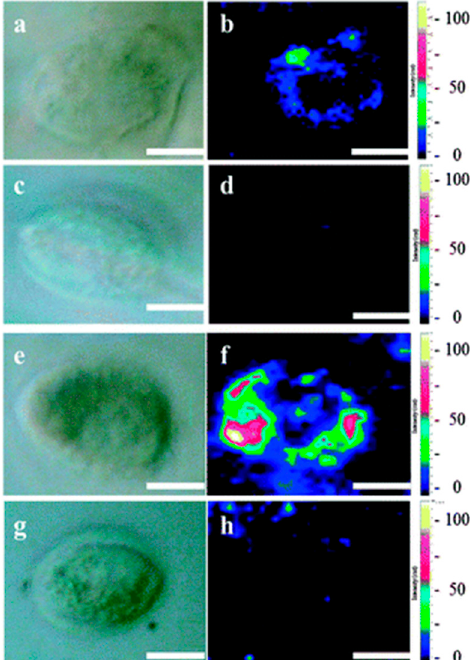
Figure 4. The cellular uptake mechanism investigations of GO and Au/GO hybrids. Hela 229 cells are incubated for 2 h with GO ( a – d ) or Au/GO hybrids ( e – h ) at 37 °C ( a , b , e and f ) and 4 °C ( c , d , g and h ), respectively. The left panels are optical images while the right panels are the corresponding Raman images (scale bar: 5 mm). Reproduced with permission [80]. Copyright 2012, Royal Society of Chemistry.